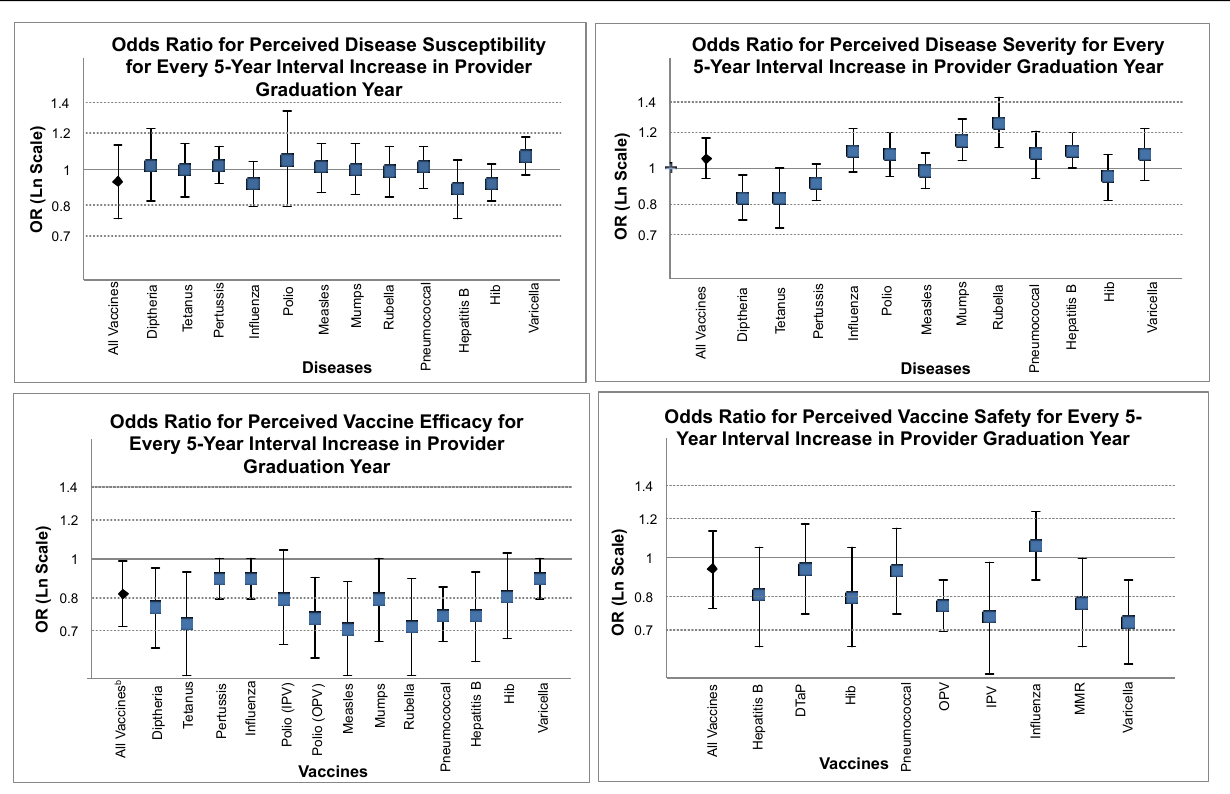
Figure 3. Odds ratio of perceived belief for every 5-year interval increase in provider graduation